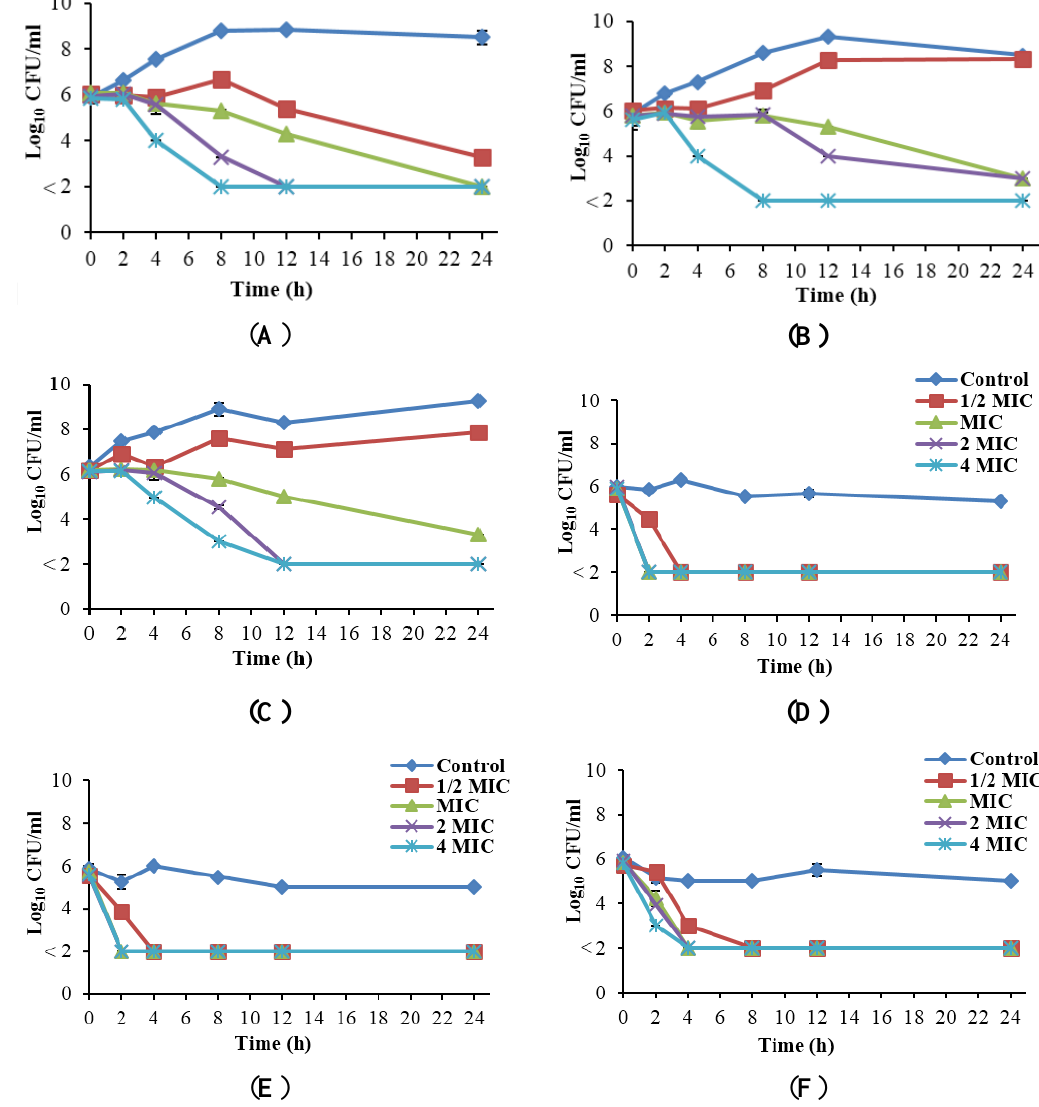
Figure 2. Numbers of Listeria monocytogenes cells, Scott A ( A ); FSL R2-574 ( B ); and PSU-KV-133 ( C ), able to form colonies on tryptic soy agar after treatment with Rhodomyrtus tomentosa ethanolic leaf extract at various concentrations, and Scott A ( D ); FSL R2-574 ( E ); and PSU-KV-133 ( F ) after treatment with the extract at various concentrations + 10% NaCl. The detection limit was 10 2